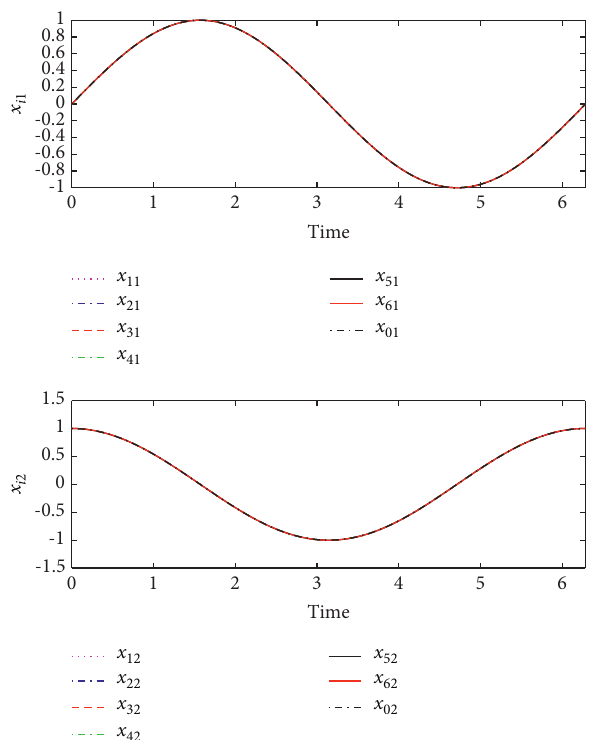
Figure 2: Consensus trajectories of six followers for Case 1 at 30th iteration.